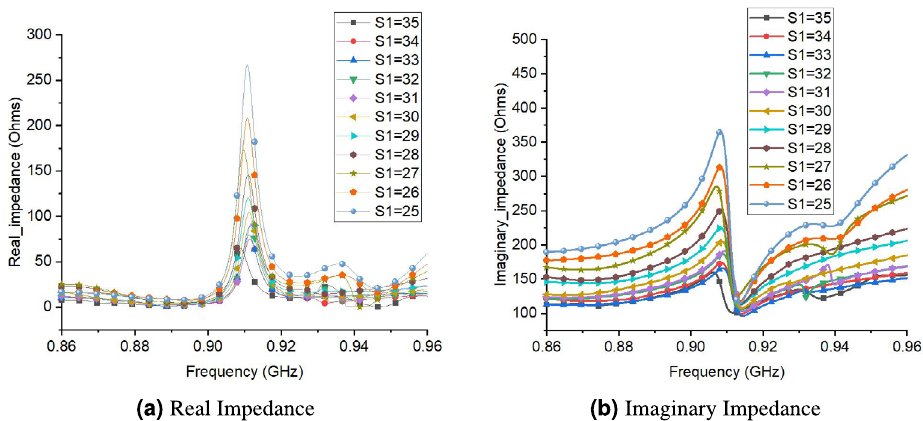
Figure 10. Performance of proposed tag design for different values of S1 (length of